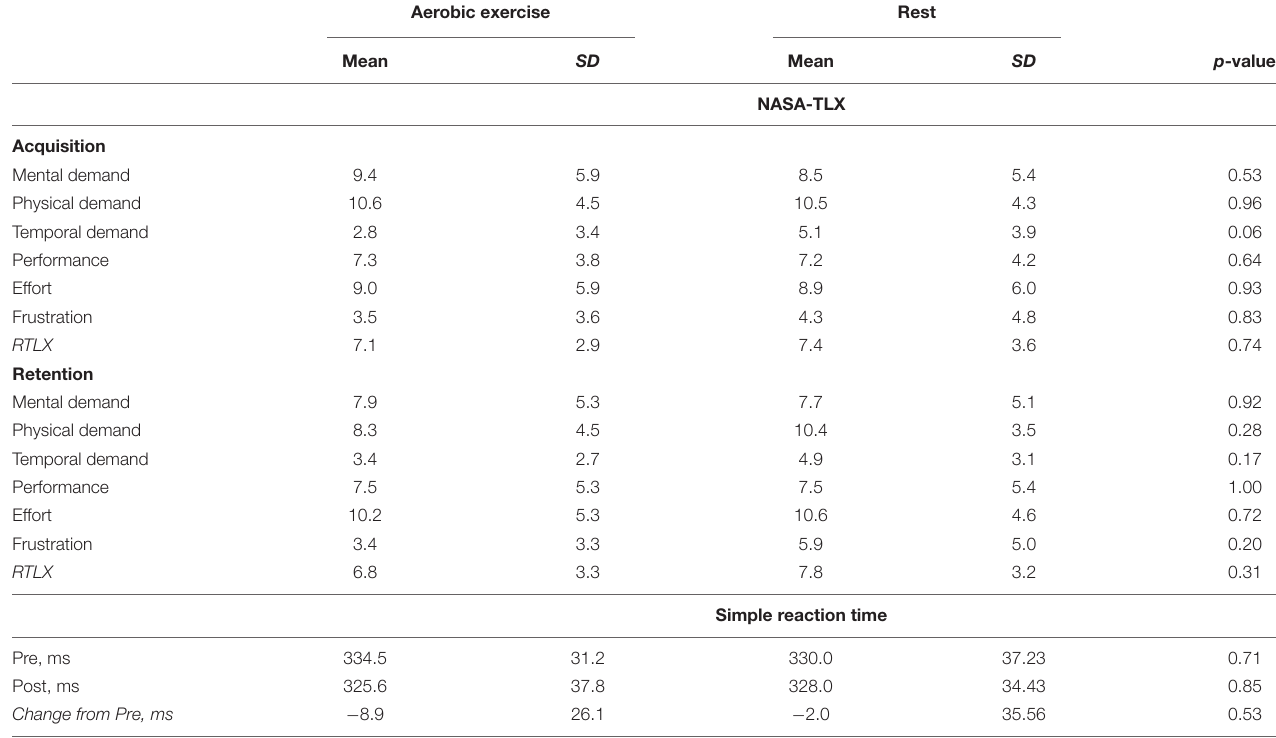
TABLE 2 | Reaction time and perceived task